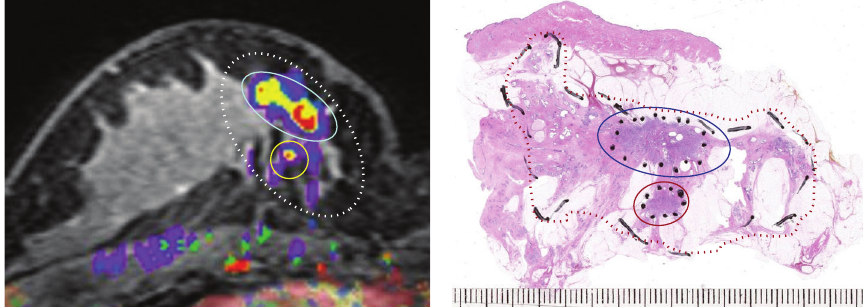
Figure 5: Magnetic resonance imaging-large-format histopathology correlation in a tumor with two invasive foci and a di ff use in situ component (combined pattern di ff use). Dotted lines indicate the extent of the disease, 57 × 30mm. Tumor size (the largest dimension of the largest invasive focus) is 16 mm. The magnetic resonance image is courtesy of Dr. Mats Ingvarsson. Table 2: Concordance of radiological and pathological size categories in 647 consecutive breast cancer cases, Falun, 2008–2011.